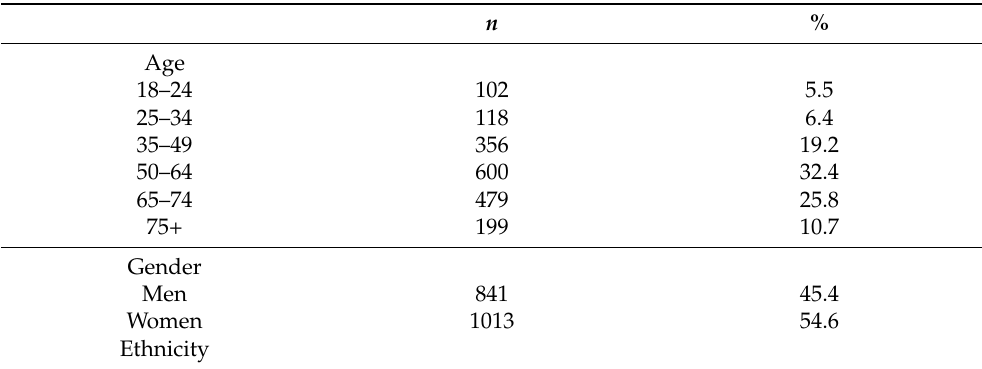
Table 1. Participant characteristics ( n =